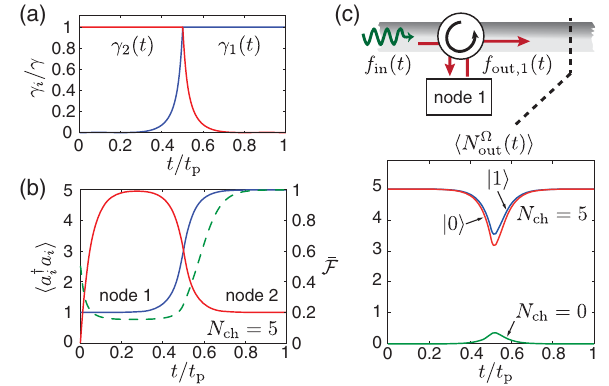
t Þ for implementing a FIG. 3. (a) Example control pulses γ i ð perfect state transfer over long distances via a thermal quantum communication channel. Here, γ 1 ð t Þ ¼ γ e γ ð t − t p Þ = ð 2 − e γ ð t − t p Þ Þ for t < t = 2 and γ 1 ð t Þ ¼ γ for t ≥ t = 2 [55]. The recapture pulse p p γ 2 , and for 2 ð t Þ is chosen to be symmetric with respect to t ¼ t p = 20 γ − 1 has been assumed. all plots, a total pulse duration of t p ¼ (b) The resulting evolution of the populations of each interme- 1 i . The green dashed diary oscillator for an initial state j ψ q i ¼ j line shows the average transfer fidelity for the same pulse sequence. (c) Expectation value of the photon number in the channel measured in between node 1 and node 2 with a detector of bandwidth Ω = γ ¼ 4 . The individual curves show the results for 0 and j ψ 1 i (green line), N 5 and j ψ 1 i N q i ¼ j q i ¼ j ch ¼ ch ¼ 5 and j ψ 0 i (red (blue line), and N q i ¼ j ch ¼